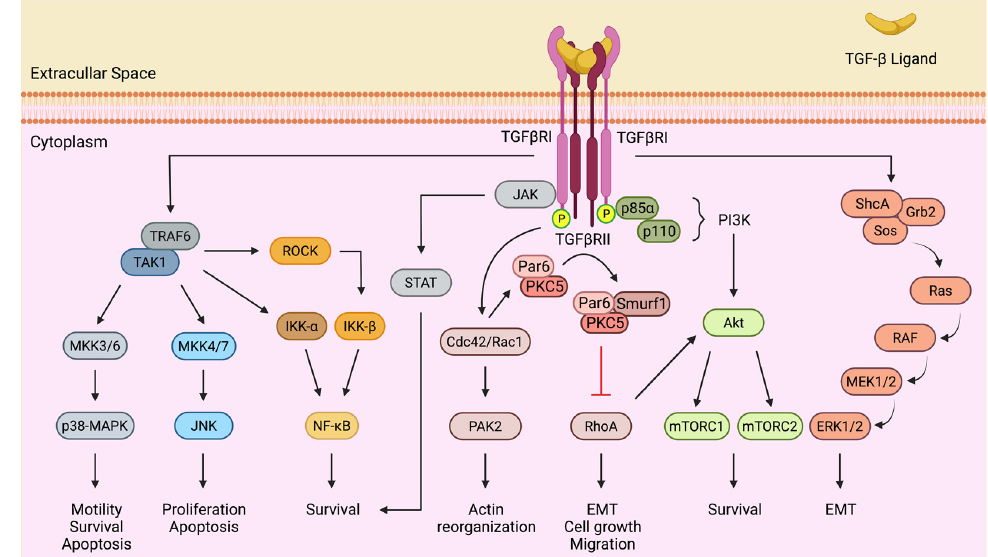
Figure 2. Non-canonical TGF- β Signaling. TGF- β can activate various Smad-independent pathways, including Jthe AK/STAT, PI3K/Akt, MAPK pathways (ERK, JNK, and p38-MAPK), NF- κ B, or small GTPases, such as RhoA, Rac1, and Cdc42. The crosstalk between TGF- β and other signaling circuits regulates multiple biological processes, including transcription, motility, survival, and apoptosis. TGF- β is a robust activator of the ERK pathway. Upon activation by ligands, TGF β RI recruits and directly phosphorylates ShcA on both tyrosine and serine residues, leading to a complex formation with Grb2 and Sos, which results in a Ras-mediated sequential activation of RAF, MEK1/2, and ERK1/2 [47]. TGF β RI is also known to induce the Smad- independent constitutive activation of the JNK and p38-MAPK cascades by the MAP ki- nase kinases (MKKs), particularly MKK4/7 and MKK3/6, respectively. Further upstream, TGF- β -activated kinase 1 (TAK1), a member of the MAP3K serine/threonine kinase fam- ily, phosphorylates and activates the MKKs [46]. TAK1 activation by TGF- β centers on the Lys63-linked polyubiquitylation of TAK1 by the TGF β RI-interacting E3 ubiquitin ligase TRAF6 [48]. The TRAF6-TAK1 axis similarly mediates the phosphorylation and activation of I κ B-kinase (IKK) α and partakes in the crosstalk of TGF- β with NF-kB signaling [34]. Alternatively, TAK1 may flux signals to NF-kB by activating Rho-associated kinase (ROCK), a downstream effector of RhoA that phosphorylates and activates IKK- β [49]. Similar outcomes may derive from direct and indirect crosstalk between the PI3K/Akt pathway and Smad-independent TGF- β signaling. In response to TGF- β stimulation, TGF- β receptors form a complex with p85 α , the regulatory subunit of PI3K, leading to the ac- tivation of Akt and downstream effectors, such as mTORC1 and mTORC2 [50,51]. Inter- estingly, TGF- β -mediated PI3K/Akt activation requires, at least in some settings, the TRAF6-dependent Lys63-linked polyubiquitylation of p85 α [51]. The ubiquitination of Akt by TRAF6 is also required for its membrane localization and phosphorylation by PI3K [52]. Notable research has focused on the Rho GTPase-selective execution of TGF- β –me- diated responses, including cytoskeletal remodeling, EMT, and cell motility, in normal and neoplastic cells [53]. In addition to RhoA, Cdc42 and Rac1 can also be activated by TGF- β receptors. In fibroblasts and epithelial cells, TGF- β -activated Cdc42 promotes p21 (Rac1) activated kinase 2 (PAK2) activation and orchestrates actin cytoskeleton meshwork organization [54]. Despite being repeatedly shown to increase the activity of Rho GTPases, TGF- β has also been reported to negatively regulate RhoA signaling in the context of EMT. Extensive data reveals that this is mediated by the TGF β RII-dependent phosphorylation of Par6, a cell polarity protein localized to tight junctions, which recruits the E3 ubiquitin